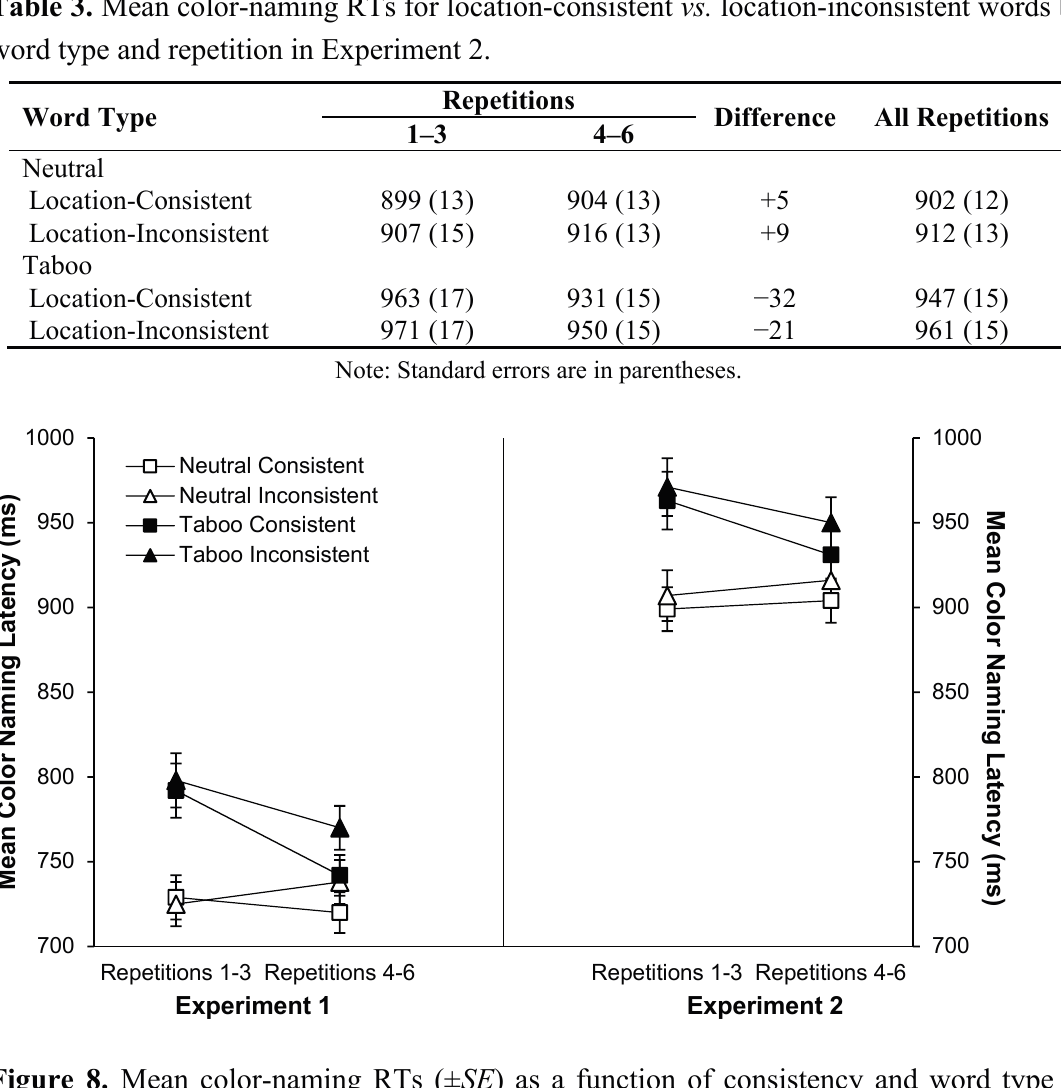
Figure 8. Mean color-naming RTs (± SE ) as a function of consistency and word type in Experiments 1 (left panel) and 2 (right